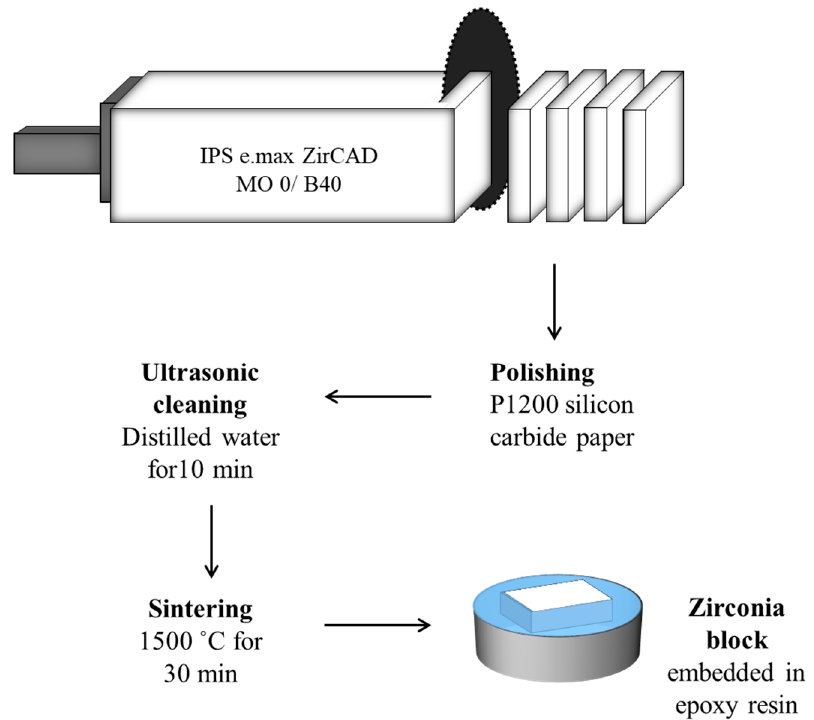
Figure 1. Schematic diagram showing the flow of steps of zirconia specimens’ preparation